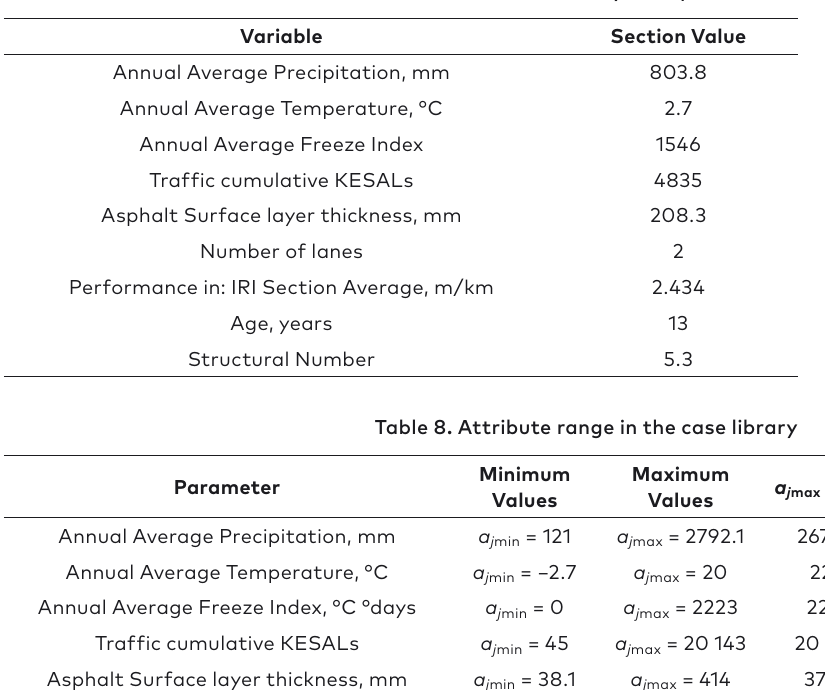
Table 7. Query case